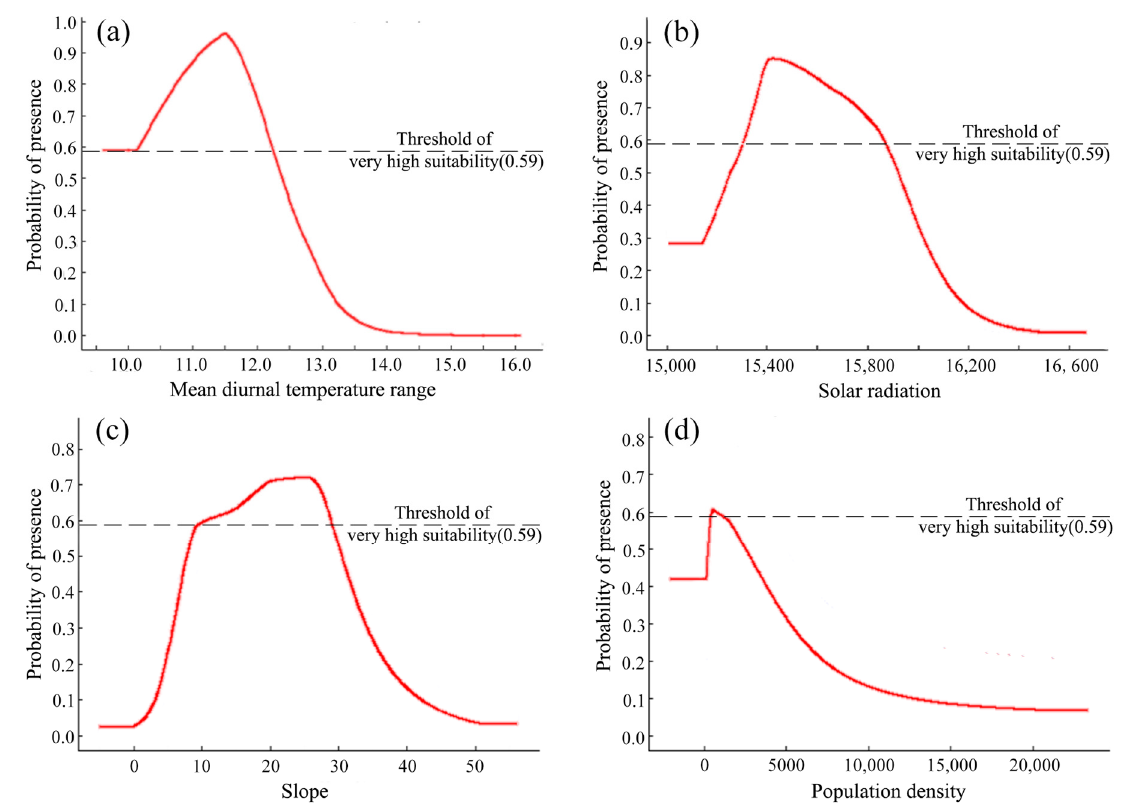
Figure 5. Jackknife test of the importance of environmental variables in MaxEnt model. ( a ) Mean diurnal temperature range (BIO2); ( b ) Solar radiation (SRAD); ( c ) Slope (SLOPE); ( d ) Population density (PD).